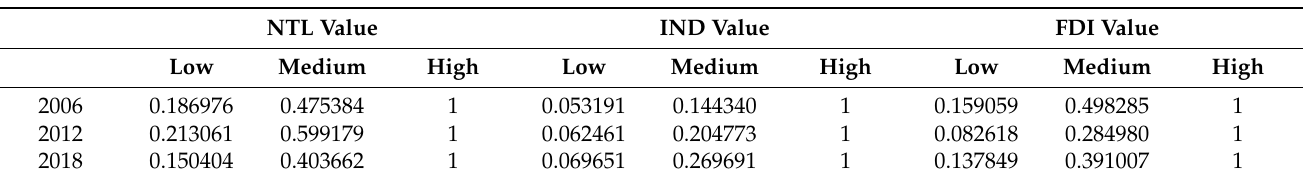
Table 1. Classification criteria of urbanization, industrialization, and globalization after normalization (based on the natural breakpoint method).